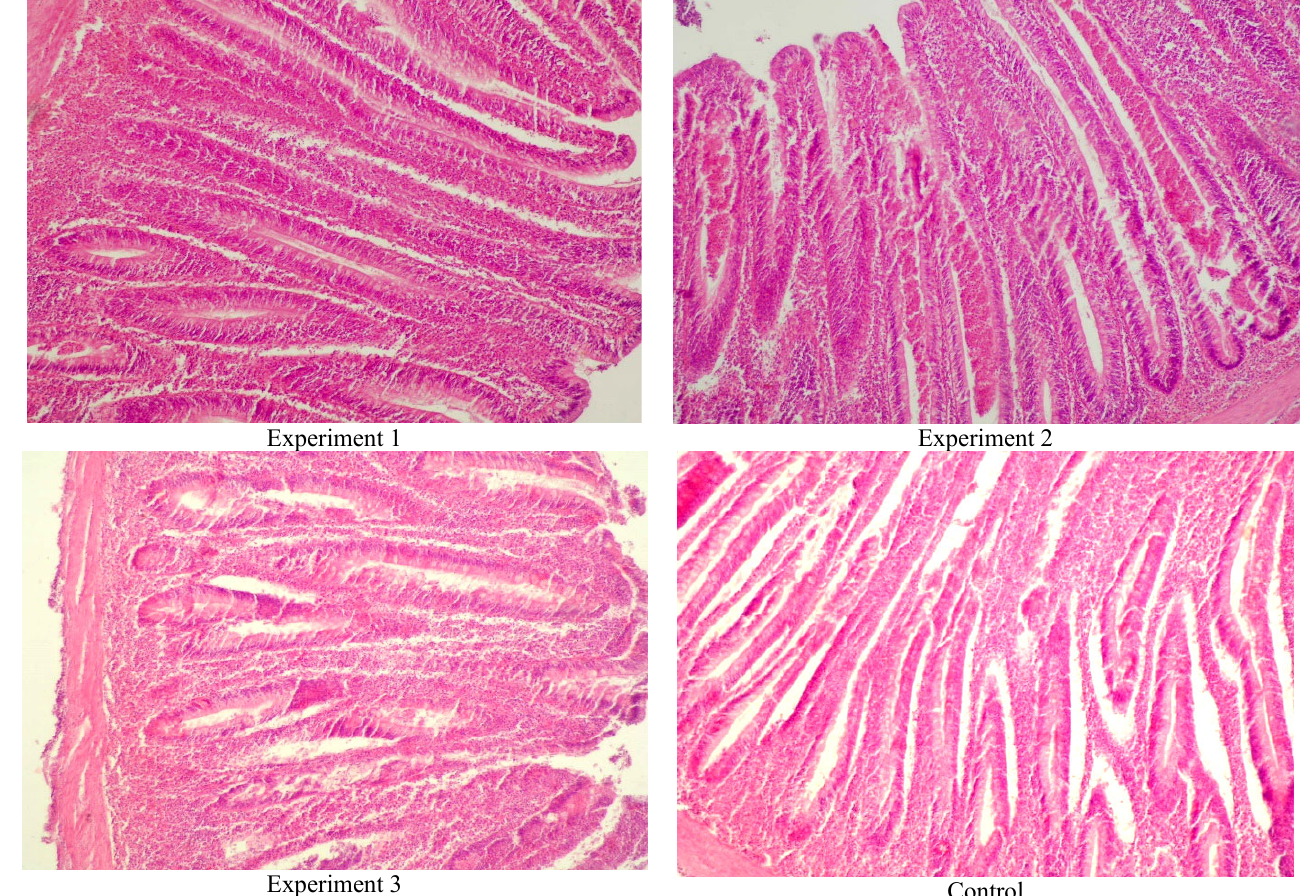
Fig. 1. Histological structure of the intestine of age -1+ carp of experimental groups. H&E. x 100